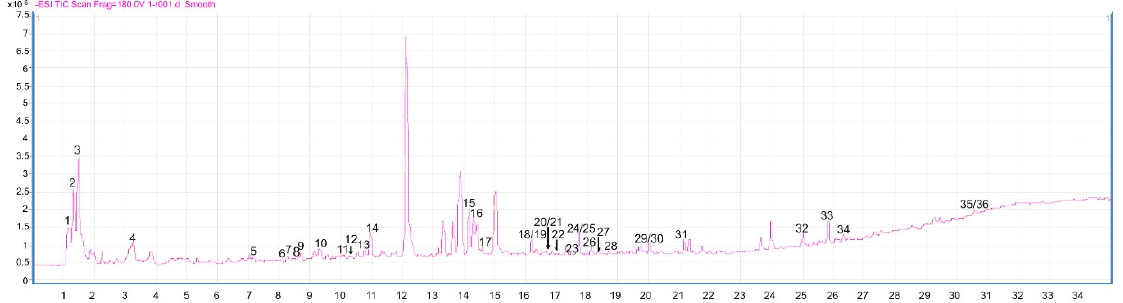
Figure 2. ESI-TIC chromatogram of leaf extracts obtained from control plants (CC), separated by LC-MS. See Table 1 for identification of the detected compounds.